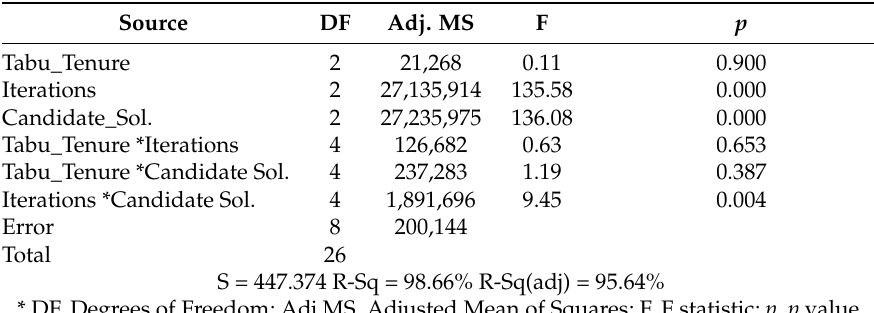
Table 9. ANOVA for total computational time in large problems.